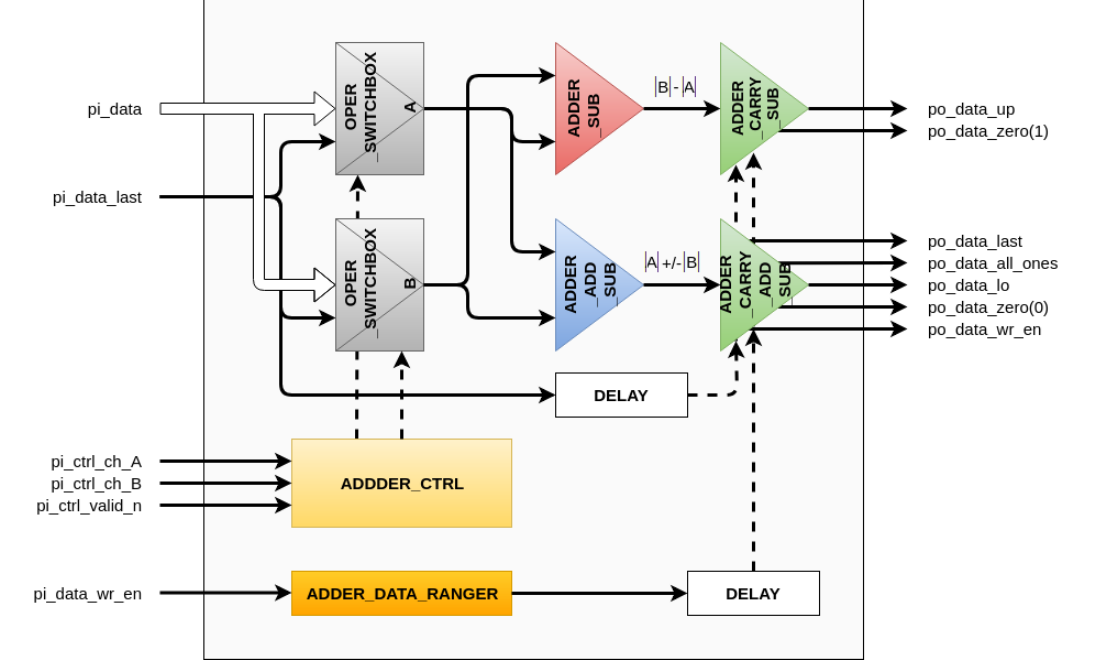
Figure 5. Block diagram of adder-subtractor unit. Table 2. Truth table allowing us to adjust sign and take corect register as result of addition